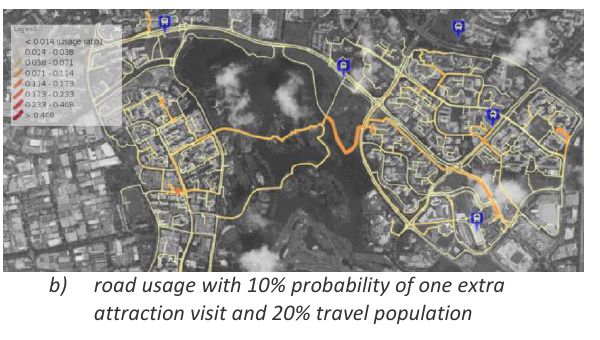
Figure 5: Outdoor walkability simulation using QUEST